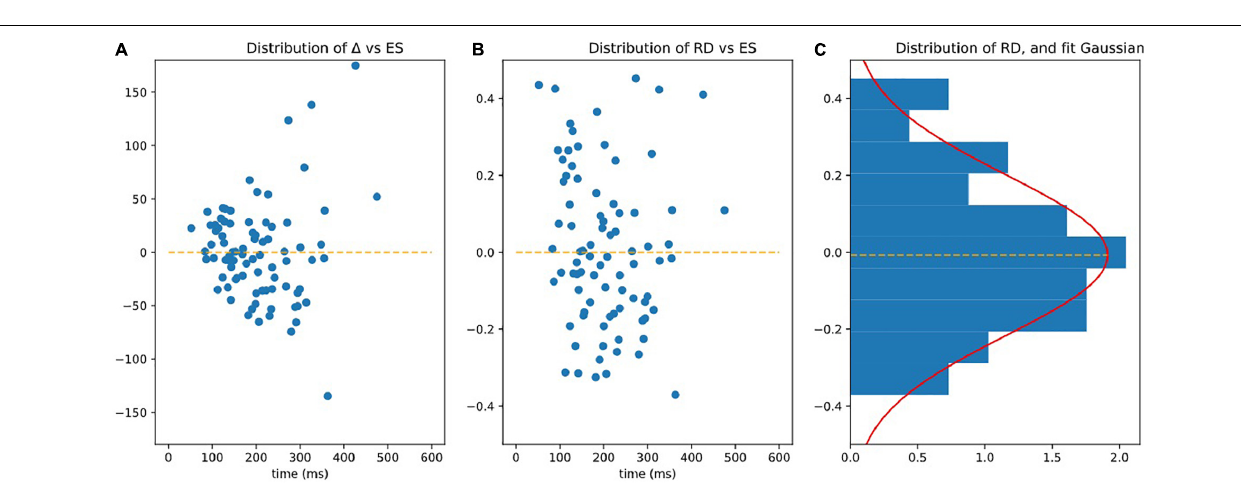
FIGURE 6 | Observing homoscedasticity of RD. (A) It is visible on figure that the variance of Delta grows with ES (slope of variance = 24.80, r -value = 0.470, p -value = 7.36e-06), meaning that Delta is not homoscedatic. (B) Represents RD = Delta/ES, which is homoscedatic (assessed by the fact that the square of RD is not correlated to ES significantly p > 0.05). (C) Is the distribution of RD fitted by Gaussian.